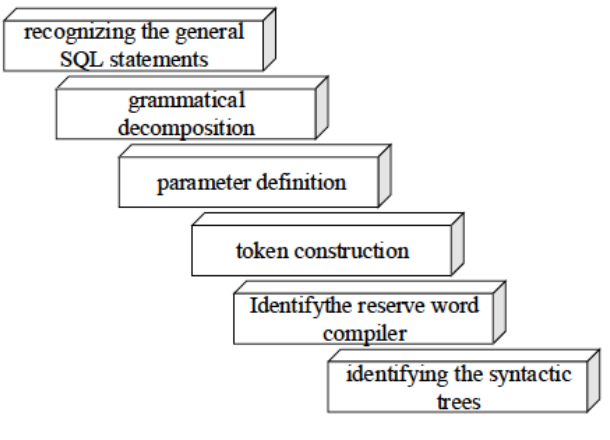
Fig. 4. Valery methodology.